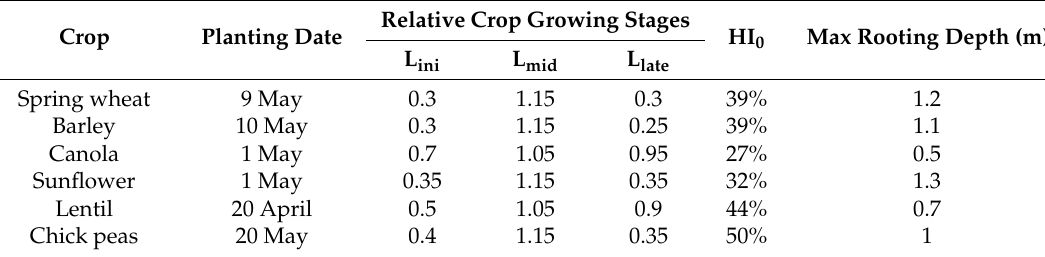
Table 1. Crop parameters used as input data to CROPWAT model.